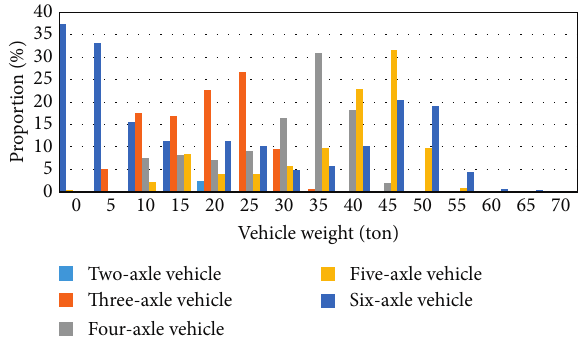
Figure 6: Weight distribution of vehicles that traveled on Jiangyin Bridge over Yangtze